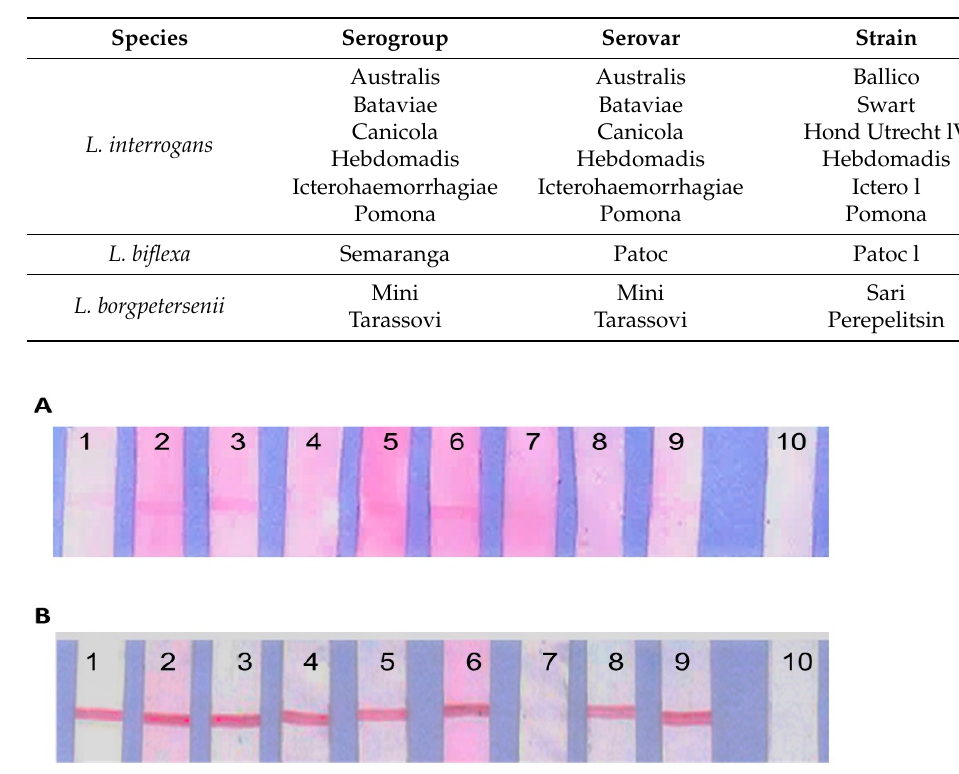
Table 2. The 9 serovars of rabbit hyperimmune sera against Leptospira spp. were purchased from the OIE Reference Laboratory for Leptospirosis and the National Collaborating Centre for Reference and Research on Leptospirosis, the Amsterdam University Medical Centers.